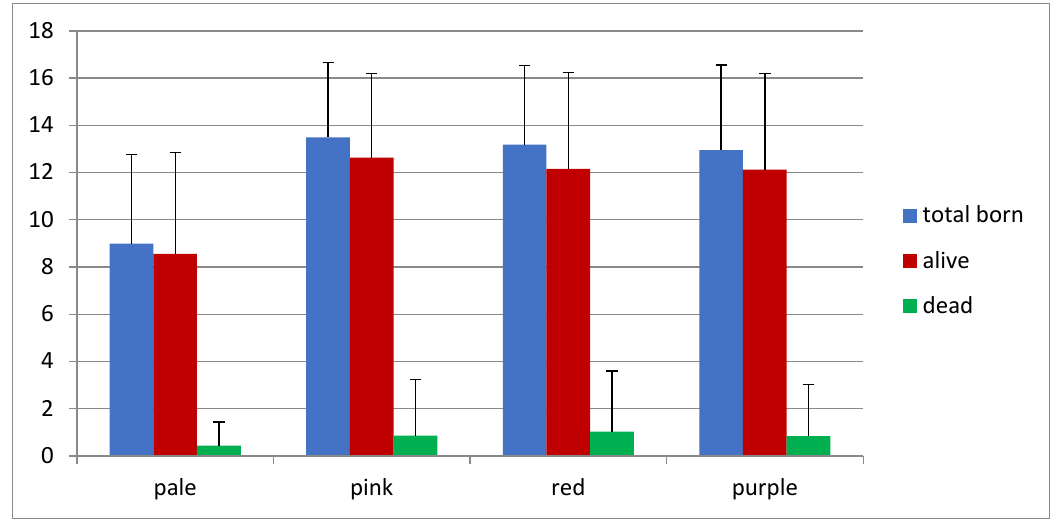
Figure 4. Prolificacy rate depending on the receptivity (vulvar color).